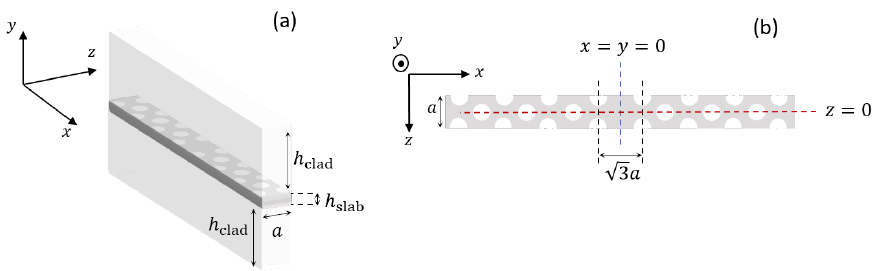
Figure 6. ( a ) Three-dimensional and ( b ) top view of the supercell to compute dispersion relation and Bloch modes of the line-defect waveguide.